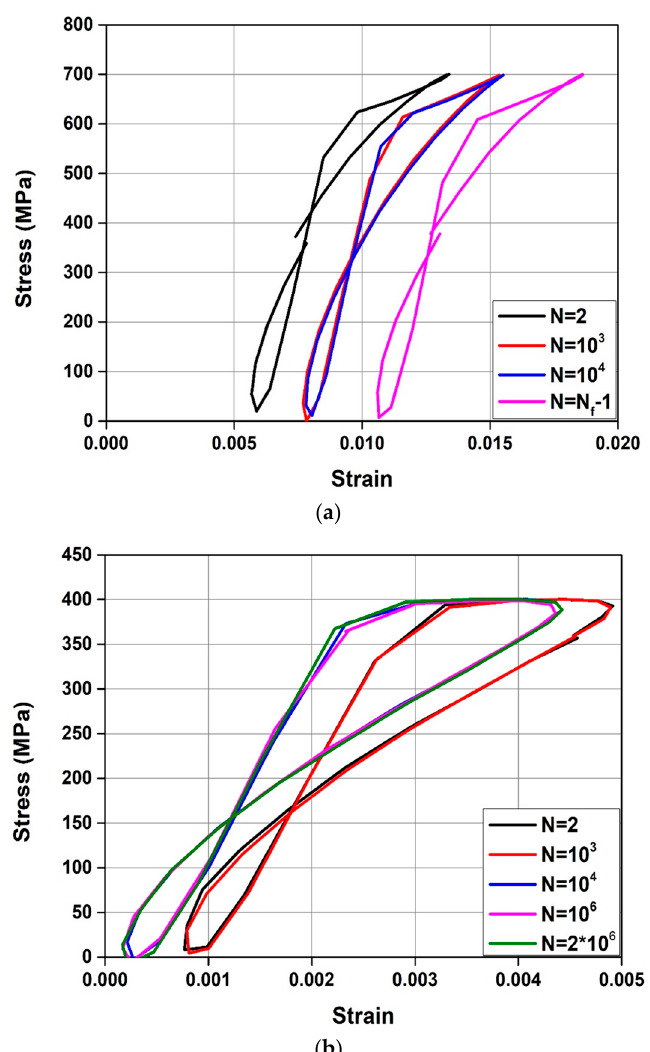
Figure 6. Stress–strain curves according to number of cycle for A-type Fe–SMA. ( a ) 700 MPa; ( b ) 400 MPa. Figure6. Stress–straincurvesaccordingtonumberofcycleforA-typeFe–SMA.( a )700MPa; ( b